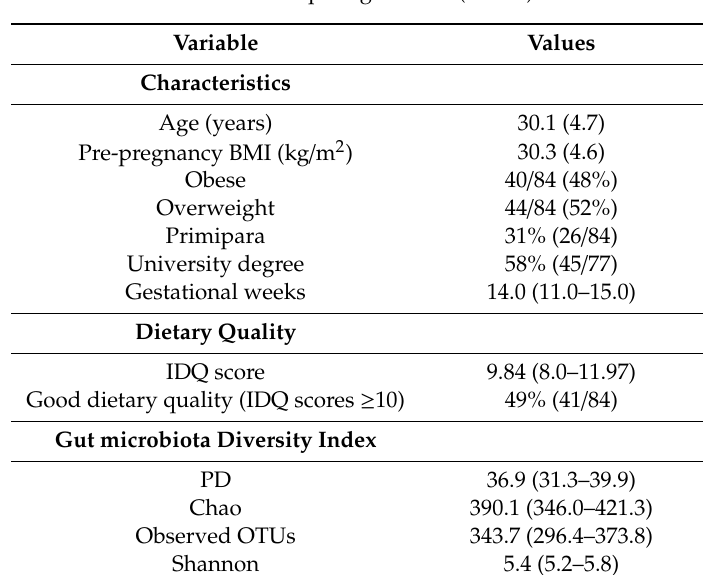
Table 1. Participating women ( n = 84) 1